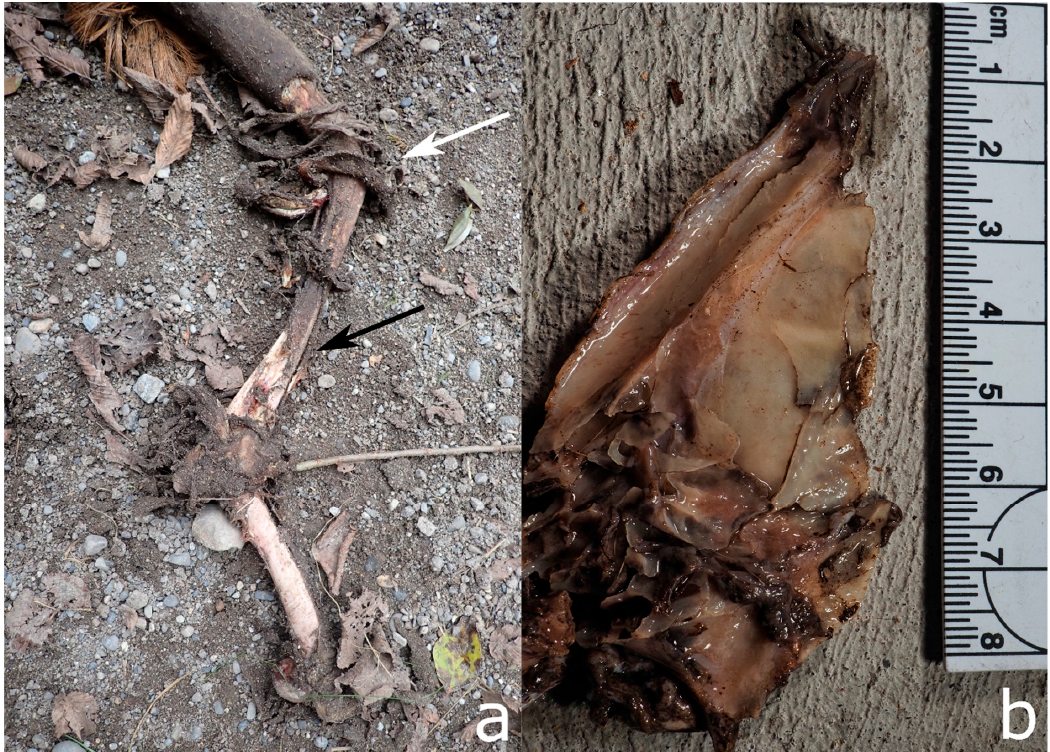
Figure 8. Wild boar-impacted bones from an experimental setting in Switzerland (Tierpark Bern): ( a ) Deer leg with detached skin due to trampling. Note the dirt-covered soft tissue still adherent (white arrow) and the spiral fracture (black arrow). ( b ) Remains of a deer skull with crushed and fractured margins.